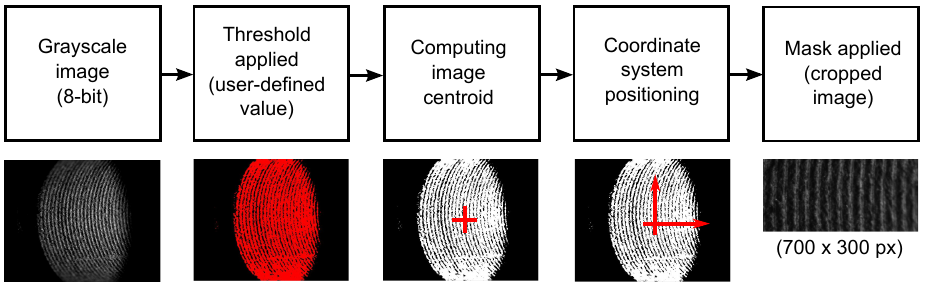
Figure 4. Image preprocessing